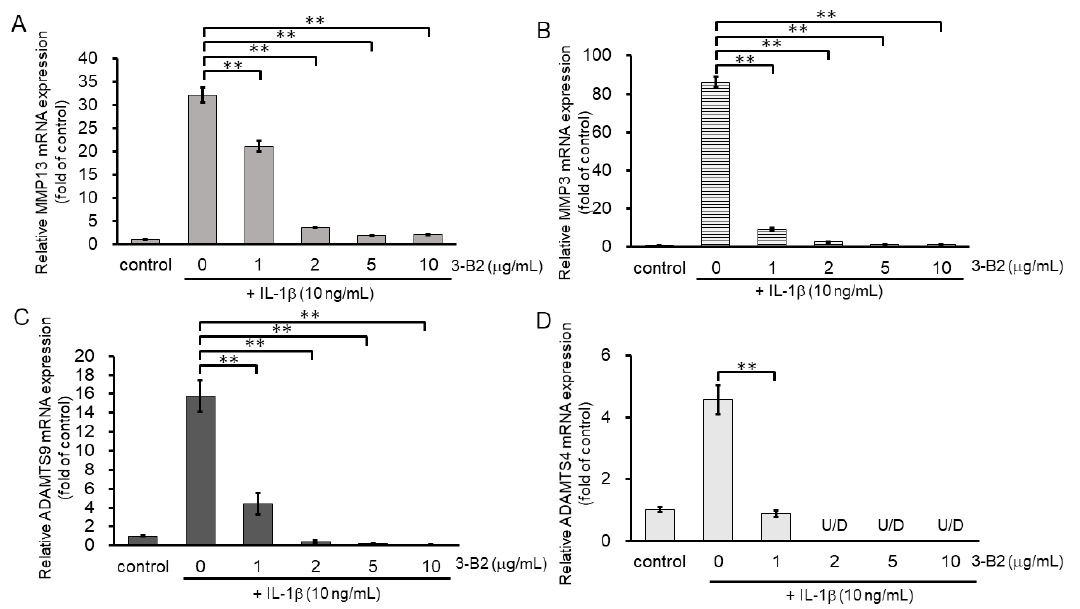
Figure 6. Inhibitory effects of 3-B2 on IL-1 β -induced MMP and ADAMTS mRNA expression. OUMS-27 cells were pretreated with 3-B2 at various concentrations (0, 1, 2, 5, and 10 μ g/mL) and then incubated with IL-1 β (10 ng/mL) for 6 h ( A ) MMP-13, ( B ) MMP3, ( C ) ADAMTS9, ( D ) ADAMTS4. Values represent mean ± SE ( n = 4 per group). ** p < 0.01.